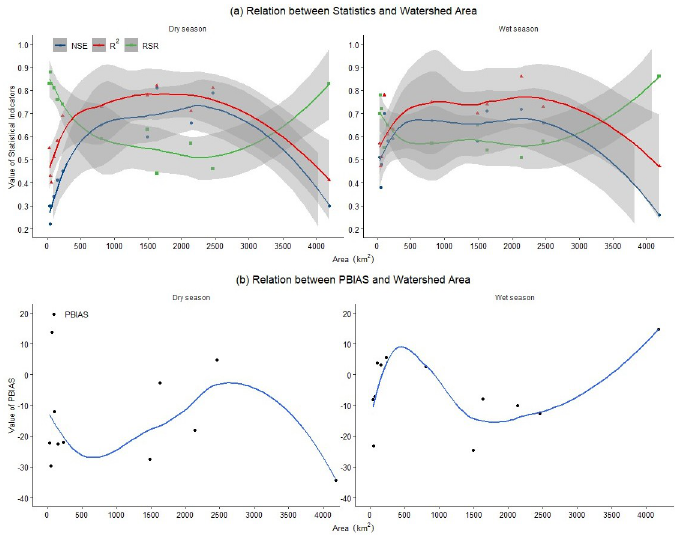
Fig 9. The relation between estimation indicators and the upstream drainage area during the wet and dry season by validated SWAT-SVR.